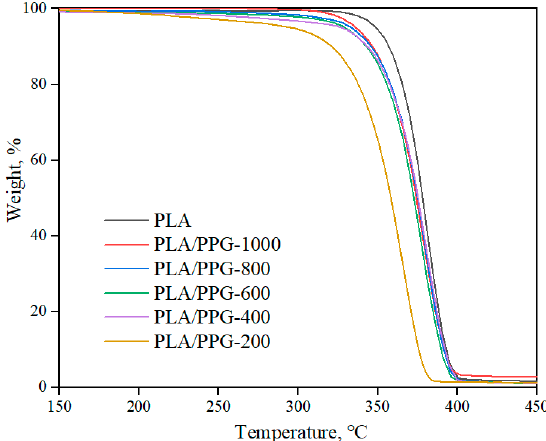
Figure 9. TGA thermograms of the neat PLA and PLA / PPG